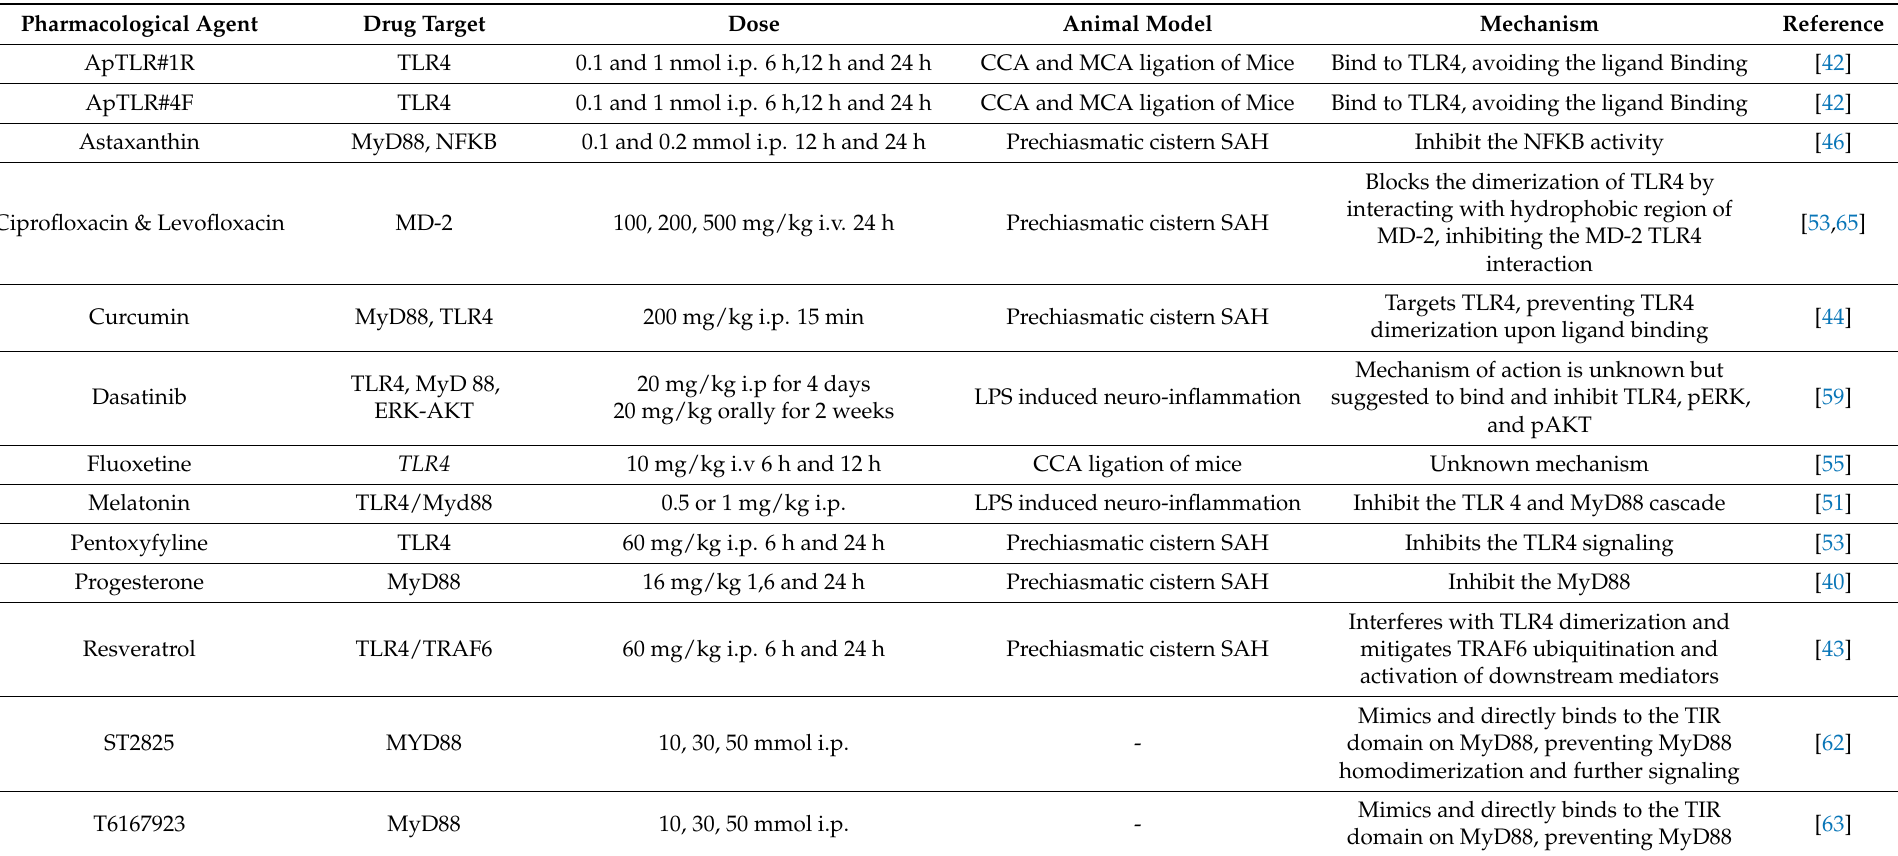
Table 1. MyD88-dependent TLR4 signaling